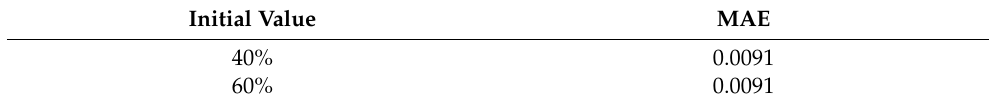
Table 5. MAE and convergence rate at 45 ◦ C.